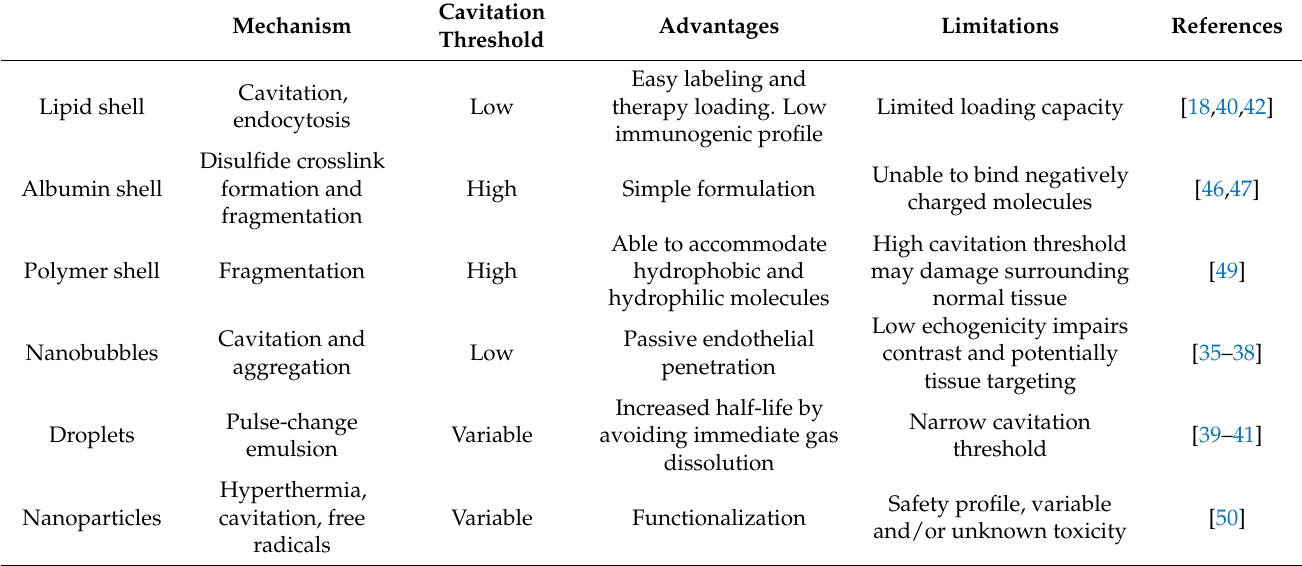
Table 1. Types of carriers and their